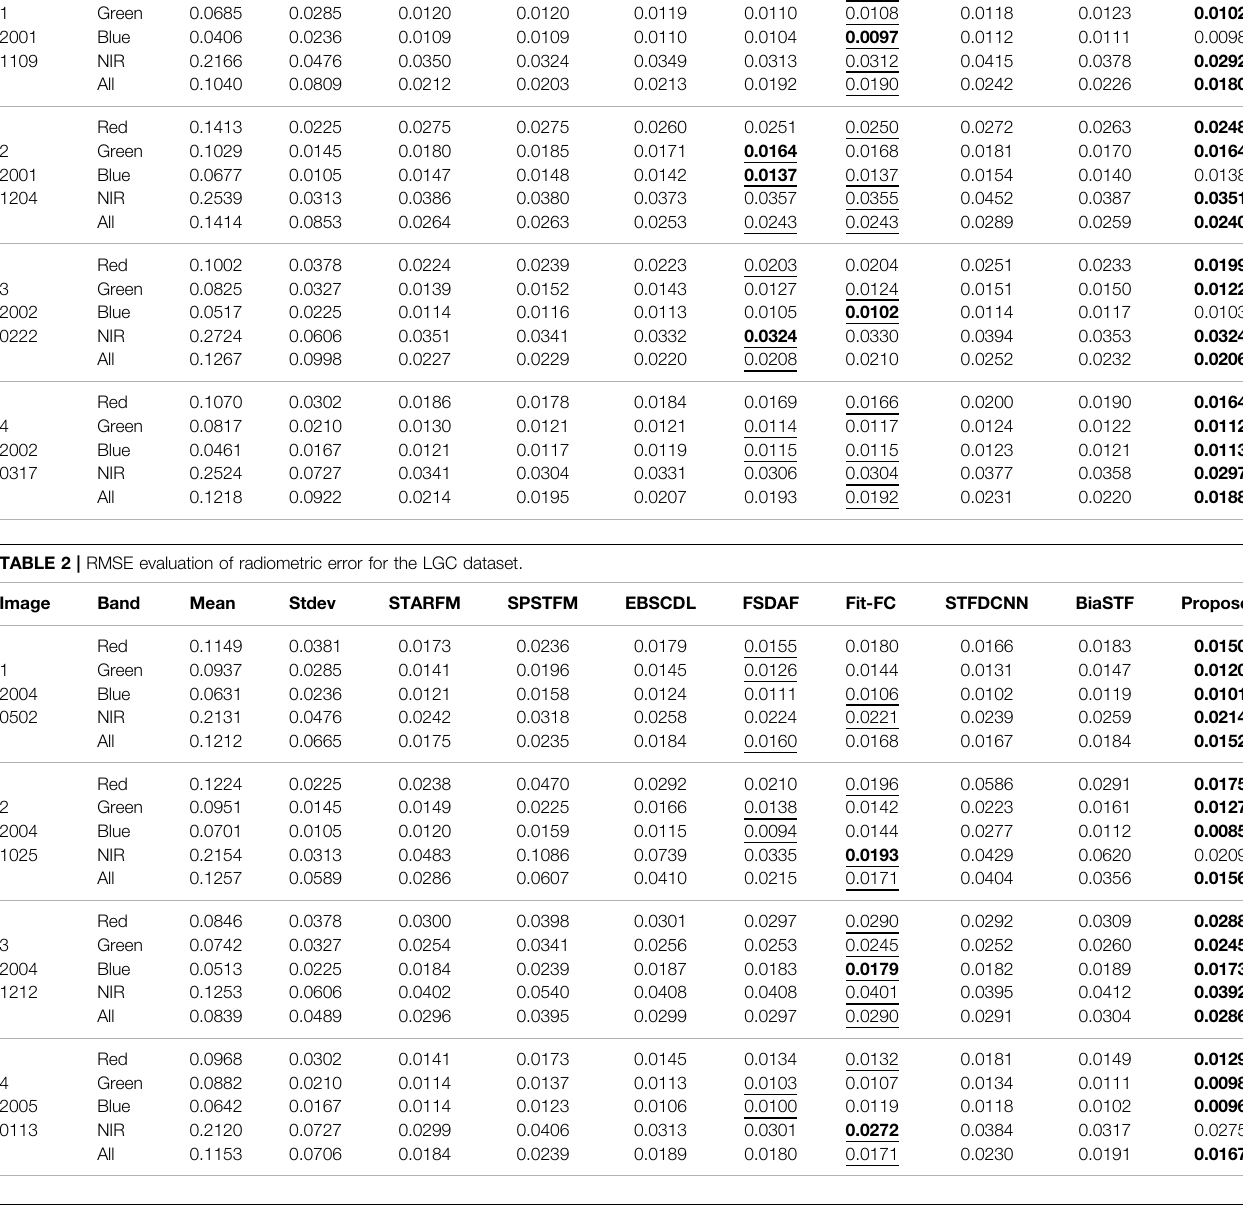
TABLE 3 | RMSE evaluation of radiometric error for the Landsat-8